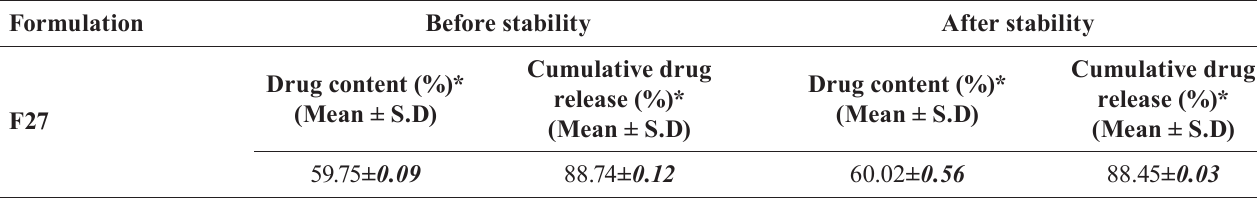
TABLE VIII - Stability data of the optimized batch formulation (F27) on before and after storage conditions Formulation Before stability After